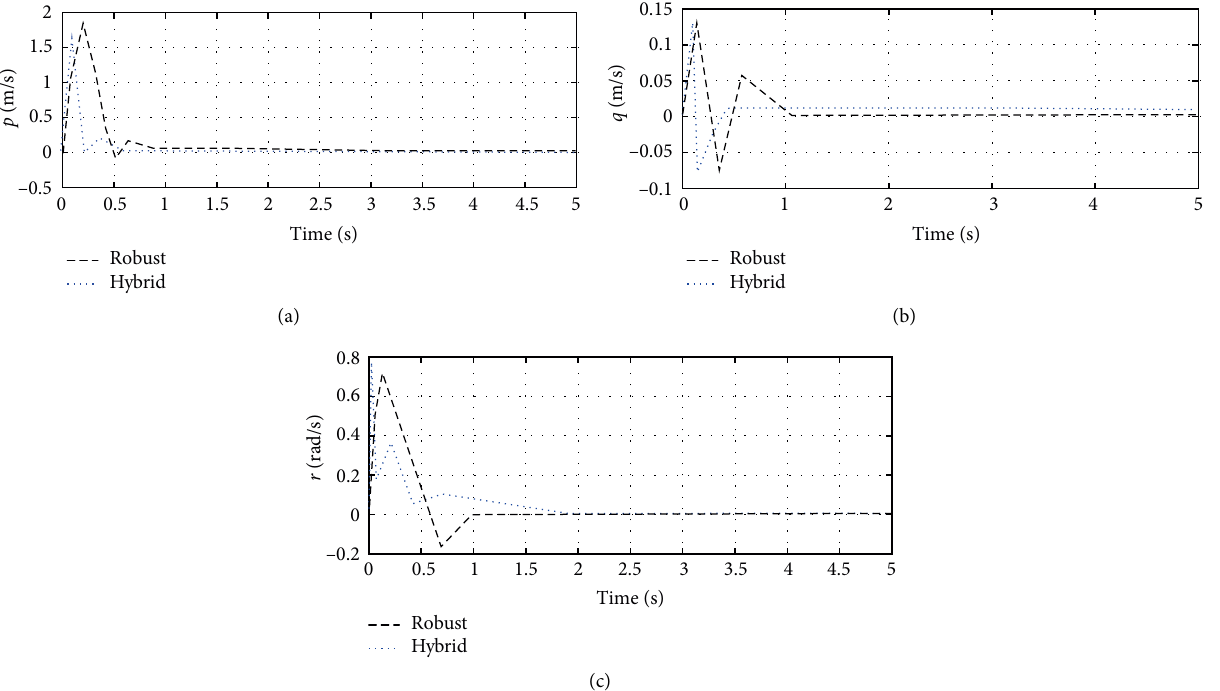
Figure 7: (a) The rotational velocity p (m/s). (b) The rotational velocity q (m/s). (c) The rotational velocity r